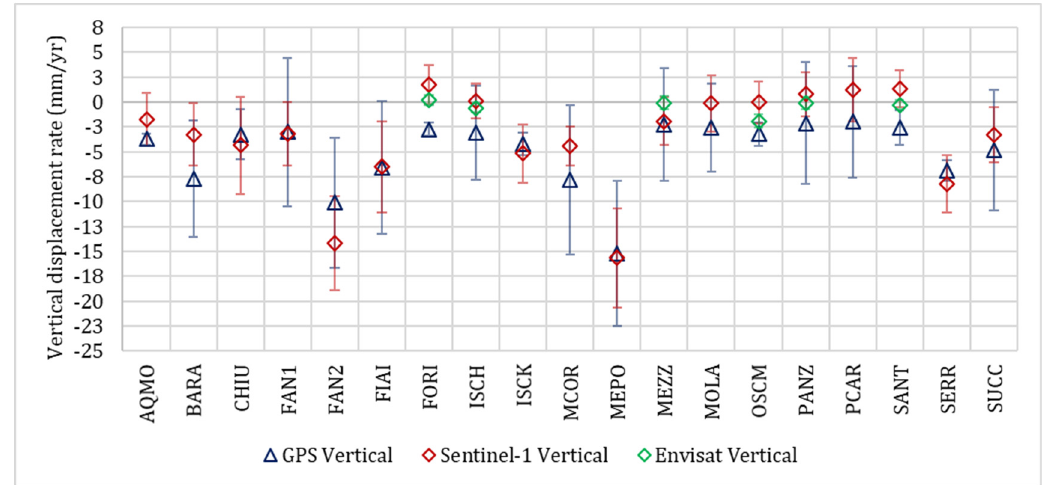
Figure 10. Comparison between GPS vertical displacement rates (blue triangles) and those retrieved through SBAS processing using Sentinel-1A data (red diamonds) and Envisat data (green diamonds).